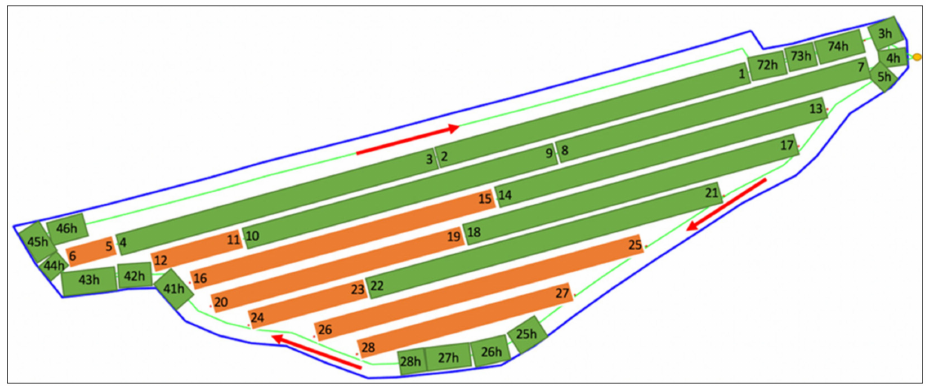
Figure 7. Sample field 1 with the proposed method